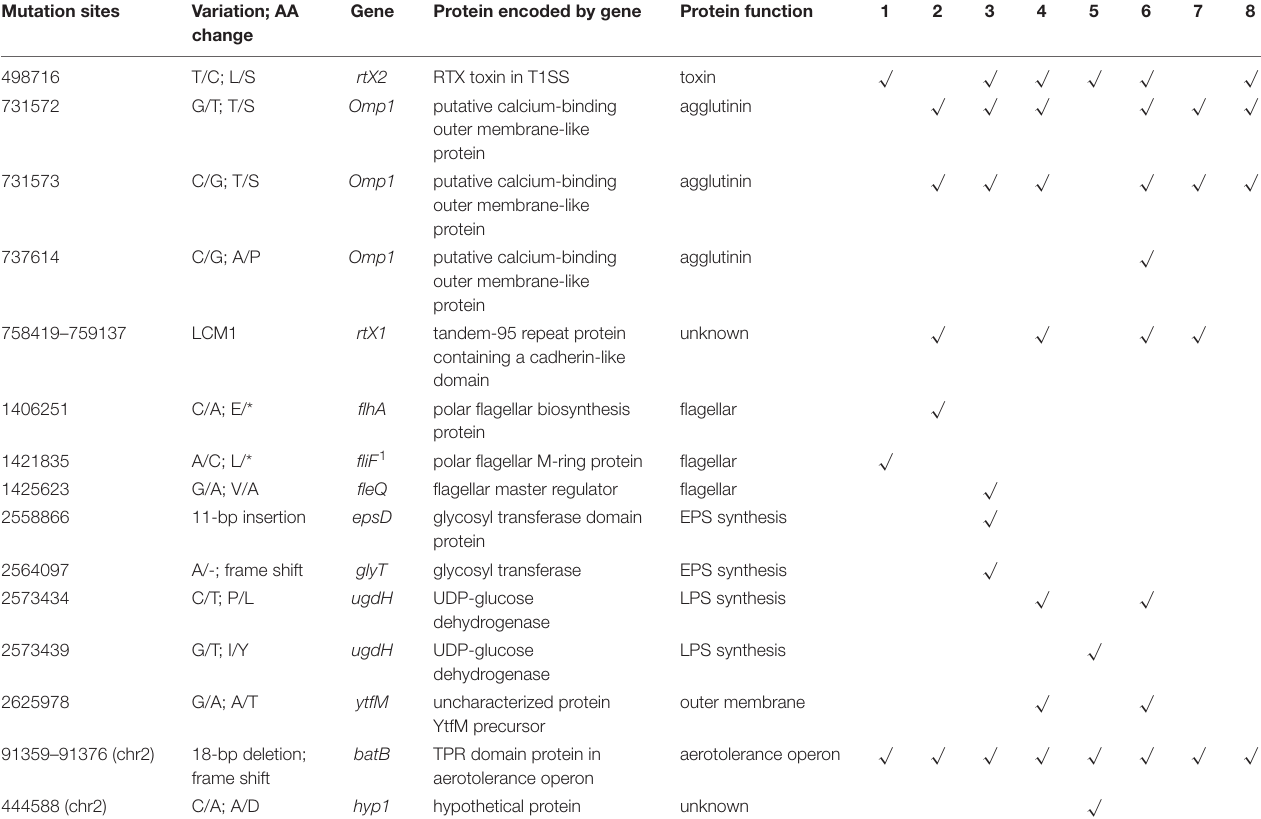
444588 (chr2) C/A; A/D hyp1 LCM1 represents one large region containing concentrated SNVs, wherein 8 PRM strains had different SNV distribution. “1–8” at the right columns represent eight PRM strainsofV.alginolyticus,VAM01,VAM02,VAM03,VAM04,VAM05,VAM06,VAM07,andVAM08,respectively.“ “*” represents a stop codon. TABLE 2 | Mutation sites in non-coding RNA genes of eight PRM strains derived from V. alginolyticus E06333. Position (nt) Variations